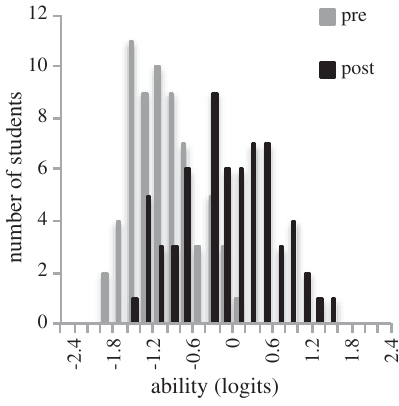
FIG. 32. The pre- and postability histograms for class